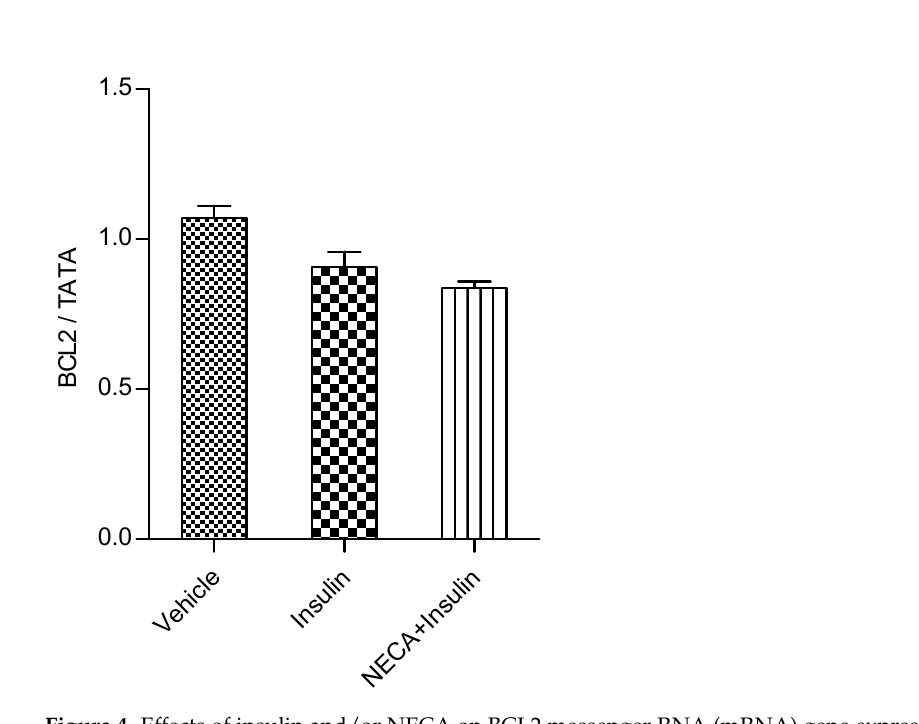
Figure 4. Effects of insulin and/or NECA on BCL2 messenger RNA (mRNA) gene expression, using charcoal serum, in rat L6 skeletal muscle myotubes. Data were analyzed with a one-way ANOVA test, then a Tukey test.